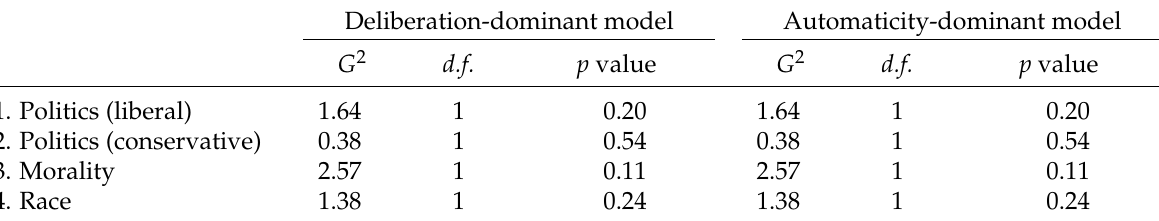
Table 1: Model fit across